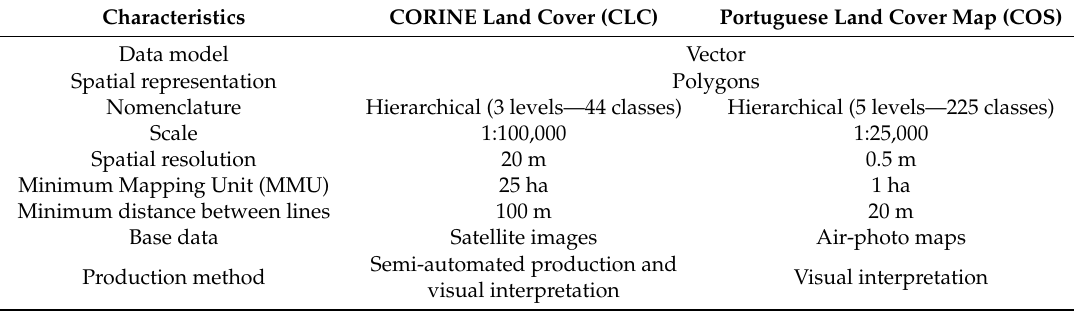
Table 1. Characteristics of the CORINE Land Cover (CLC) and the official Portuguese Land Cover Map (COS) datasets.